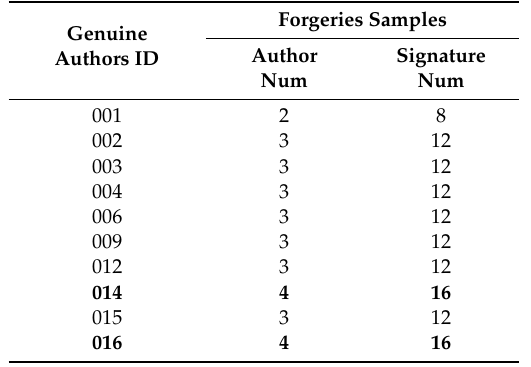
Table 2. The summary of the forged signature samples in SigComp 2011.